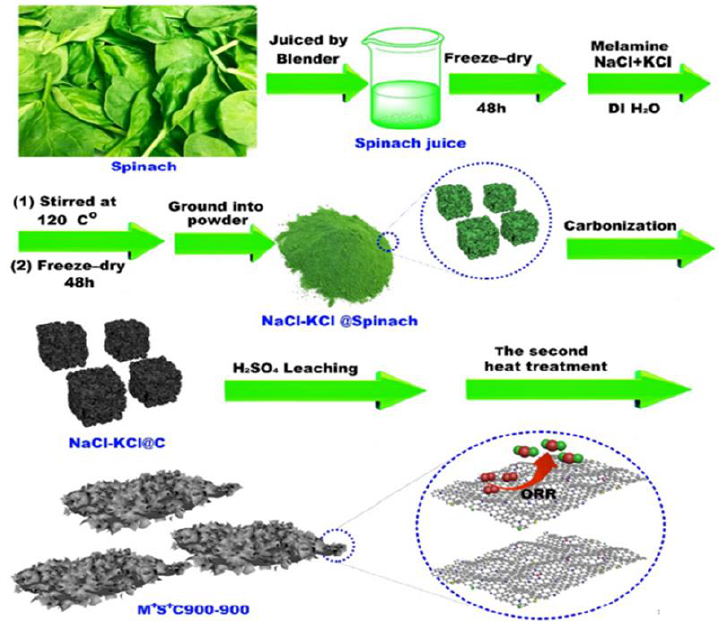
Figure 15. Schematic procedure for preparation of carbon nanosheets derived from spinach as electrocatalysts for ORR. Adapted with permission from ref. [99].